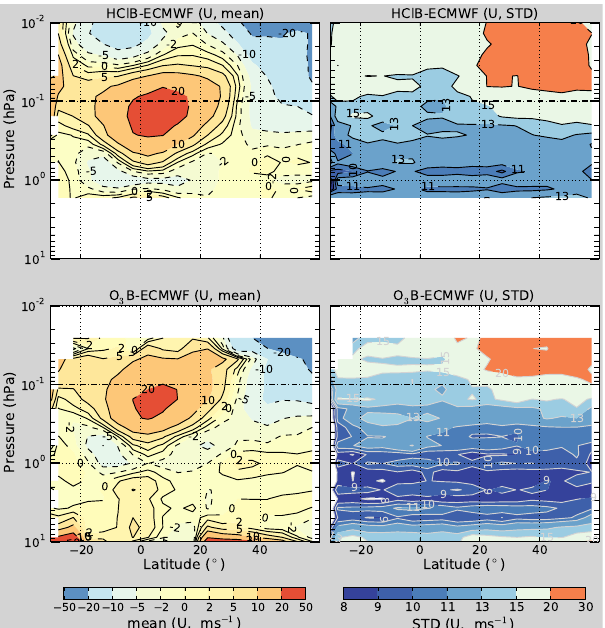
Fig. 8. Comparison of the near meridional winds retrieved from band-B with the operational ECMWF analysis. Data with a line- of-sight orientation between ± 10 ◦ from the meridional direction are used and ECMWF winds are projected along the line-of-sight direction. Upper panels: mean (left panel) and standard deviation (right panel) of the differences for profiles retrieved from the HCl lines. Lower panels: same as for the upper panels but for profiles retrieved from the O 3 line. Data between November 2009 to April 2010 have been selected.